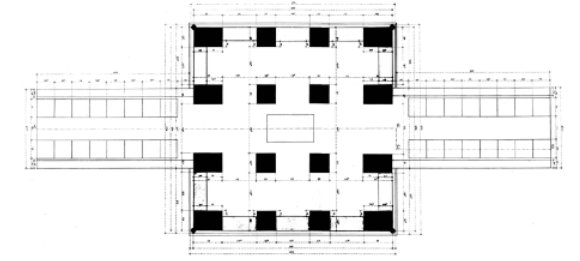
Figure 5 . Layout of the White